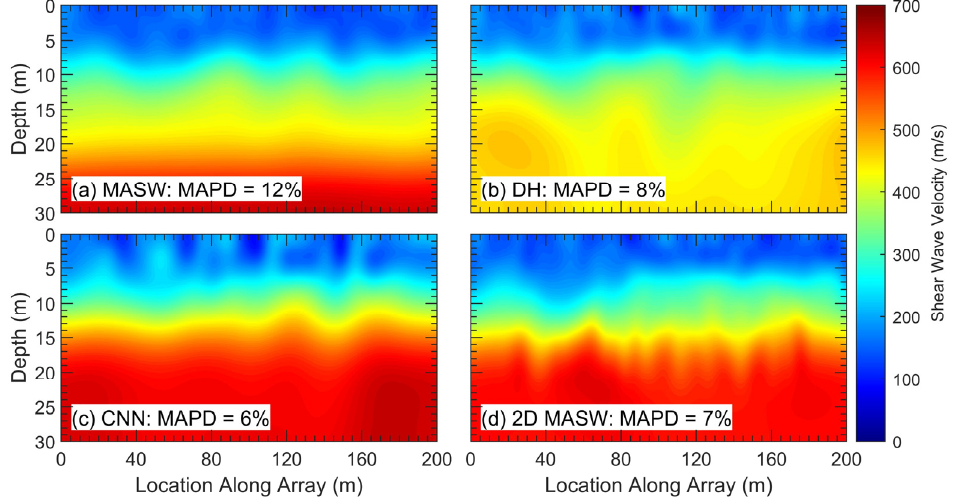
Figure 6. The updated 2D V S images at the end of FWI Stage 1 (10 to 15 Hz) for the: ( a ) MASW, ( b ) DH, ( c ) CNN, and ( d ) 2D MASW starting models. Mean absolute percent difference values are shown for each updated V S image relative to their respective starting V S image.